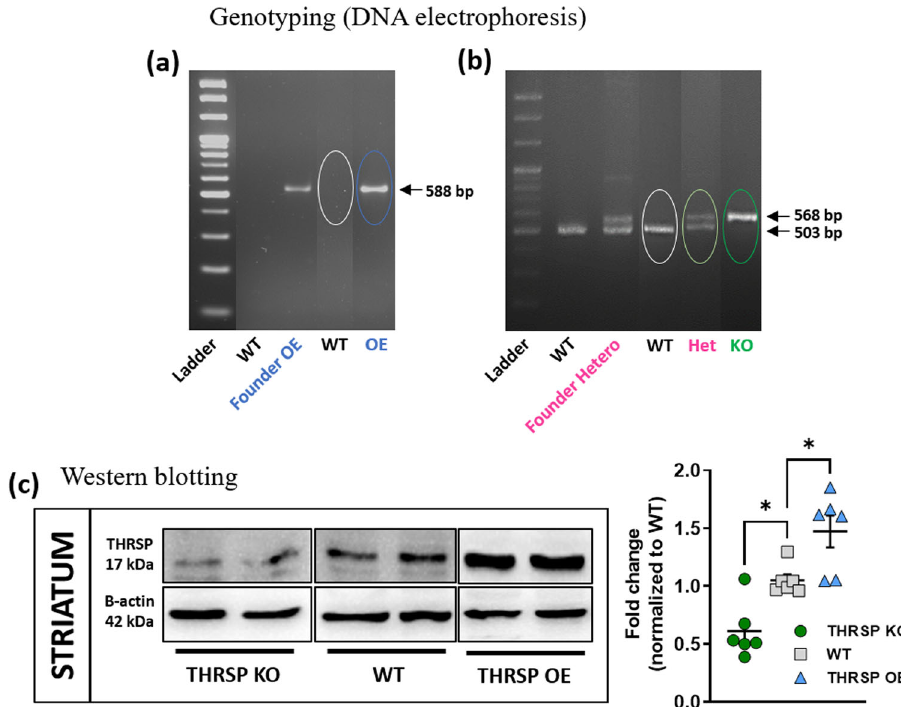
Fig. 1 The con fi rmation of mouse genotype and striatal THRSP levels. Before the start of each experiment, genotyping was conducted in 3-week-old mice using tail samples. a The THRSP OE mice show one band at 588 bp; in contrast, b the Hetero mice show two bands (568 and 503 bp), and KO mice show one band (568 bp). c Western blot using striatal tissue samples con fi rm the overexpression of THRSP protein levels in THRSP OE mice and the reduced expression in THRSP KO mice ( n = 6 mice/group; c one-way ANOVA, F (3,20) = 15.0, P < 0.001). Values are presented as the mean ± S.E.M. * P < 0.05, by one-way ANOVA with Bonferroni ’ s multiple comparisons relative to